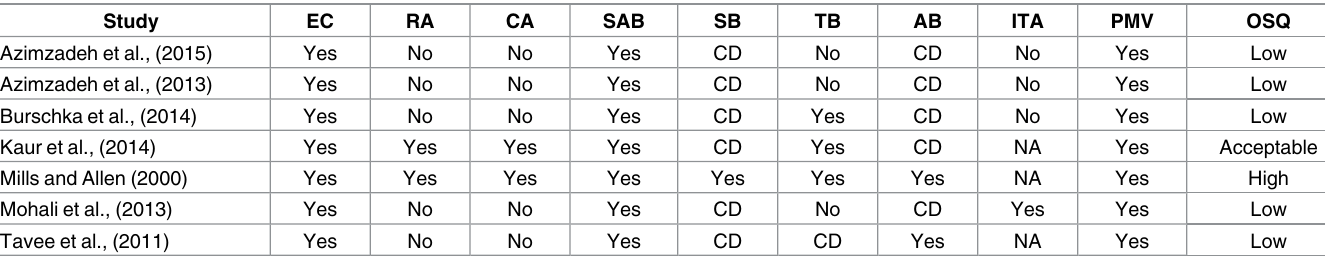
Table 1. Study quality assessmentfor experimental studies. Study